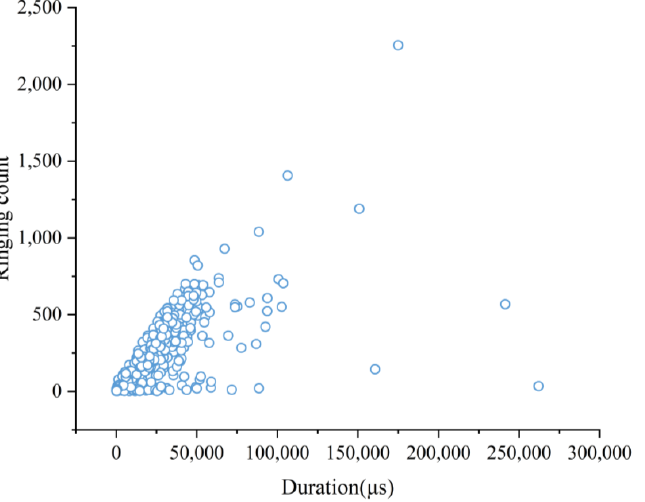
Figure 13. Ring count-duration correlation diagram of cable noise signal of Caihong Bridge.